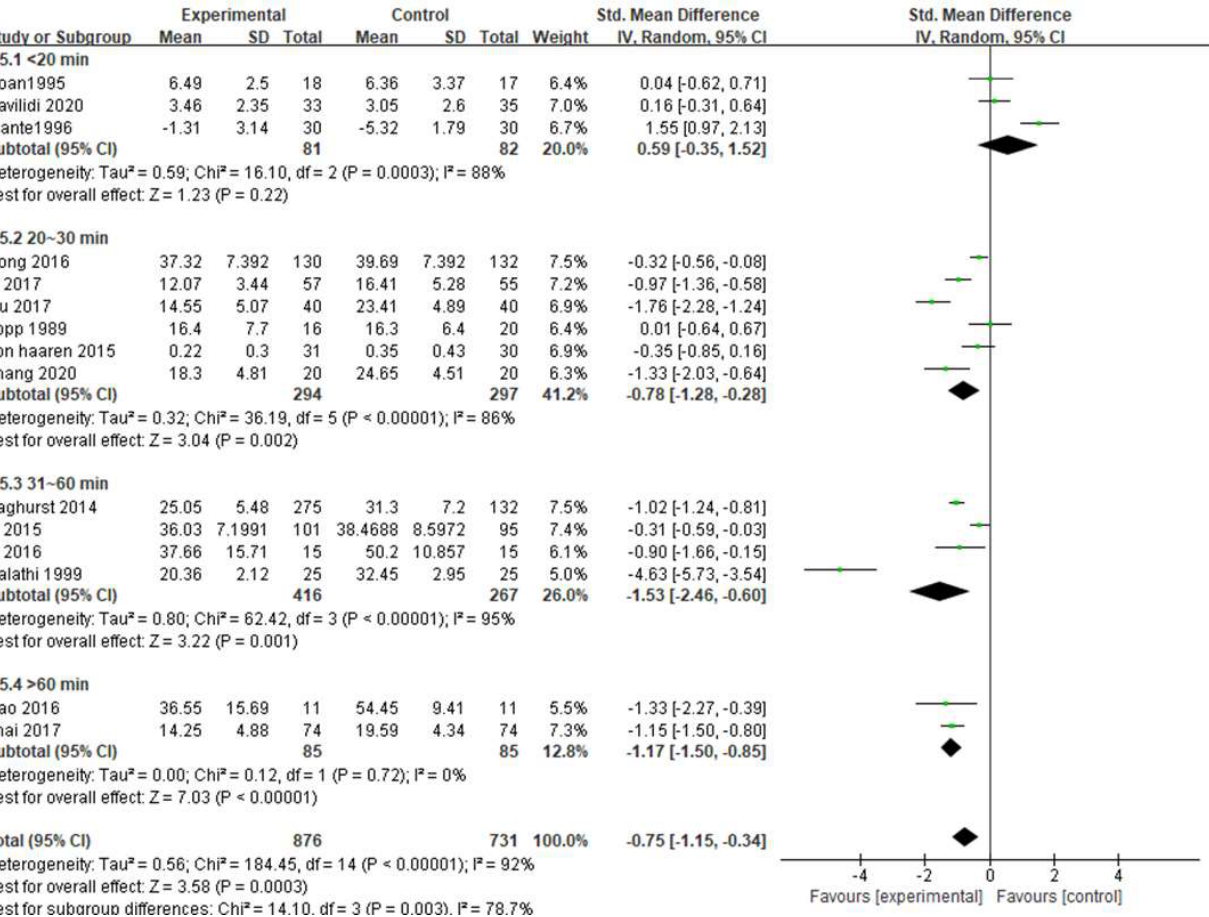
Figure 10. Subgroup analysis of exercise duration [17–20,22–32].